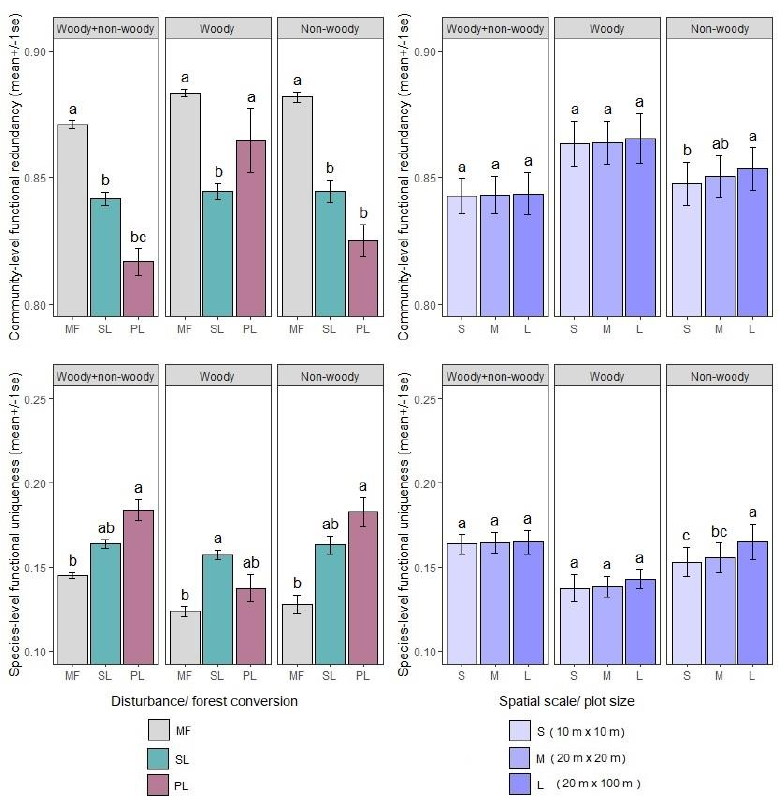
Figure 6. Variations in the species versus functional diversity relationships concerning habitat disturbance, spatial scale, and vegetation layers. Bars marked with the same letters do not differ significantly at α = 0.05, as identified by Tukey’s post-hoc test. See Table S2 for detailed statistical results.